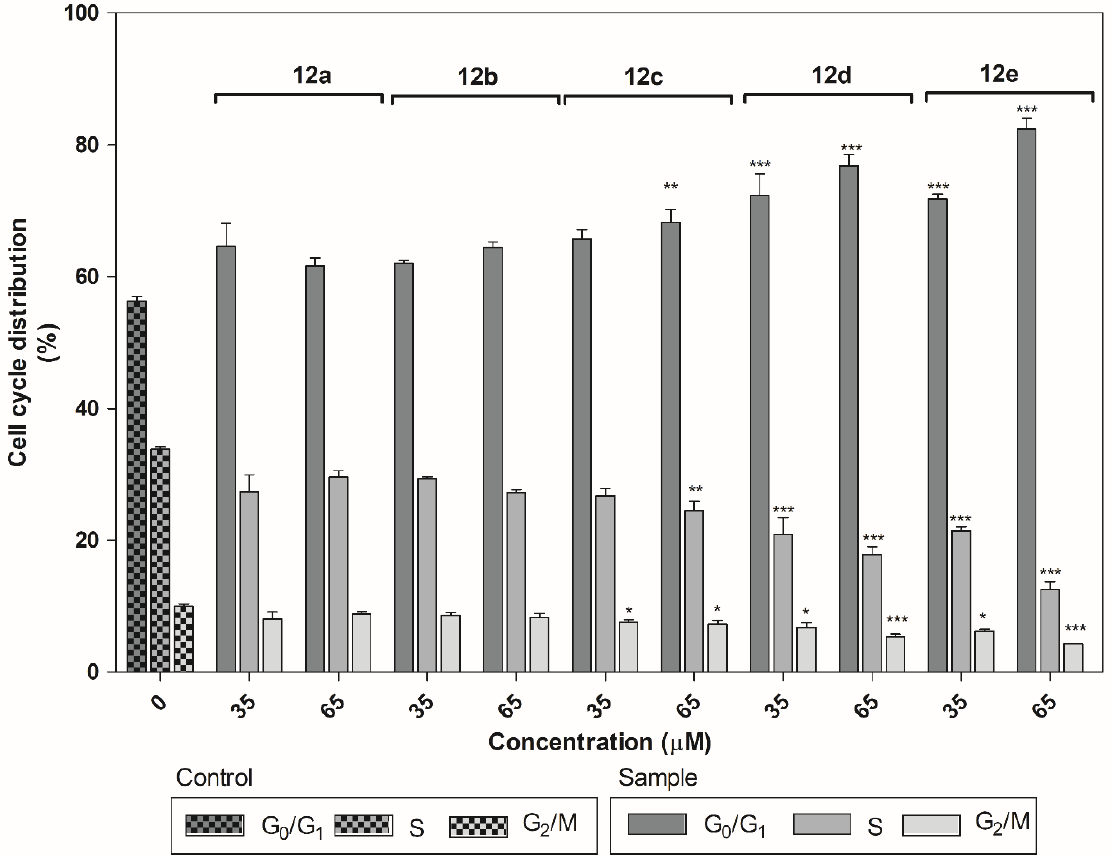
Figure 6. Effect of biscoumarin derivatives 12a – e on cell cycle distribution in A549 cells. The cells were treated with the indicated concentrations of compounds for 24 h. Statistical significance * p < 0.05; ** p < 0.01; *** p < 0.001 for each experimental group compared to the untreated cells.